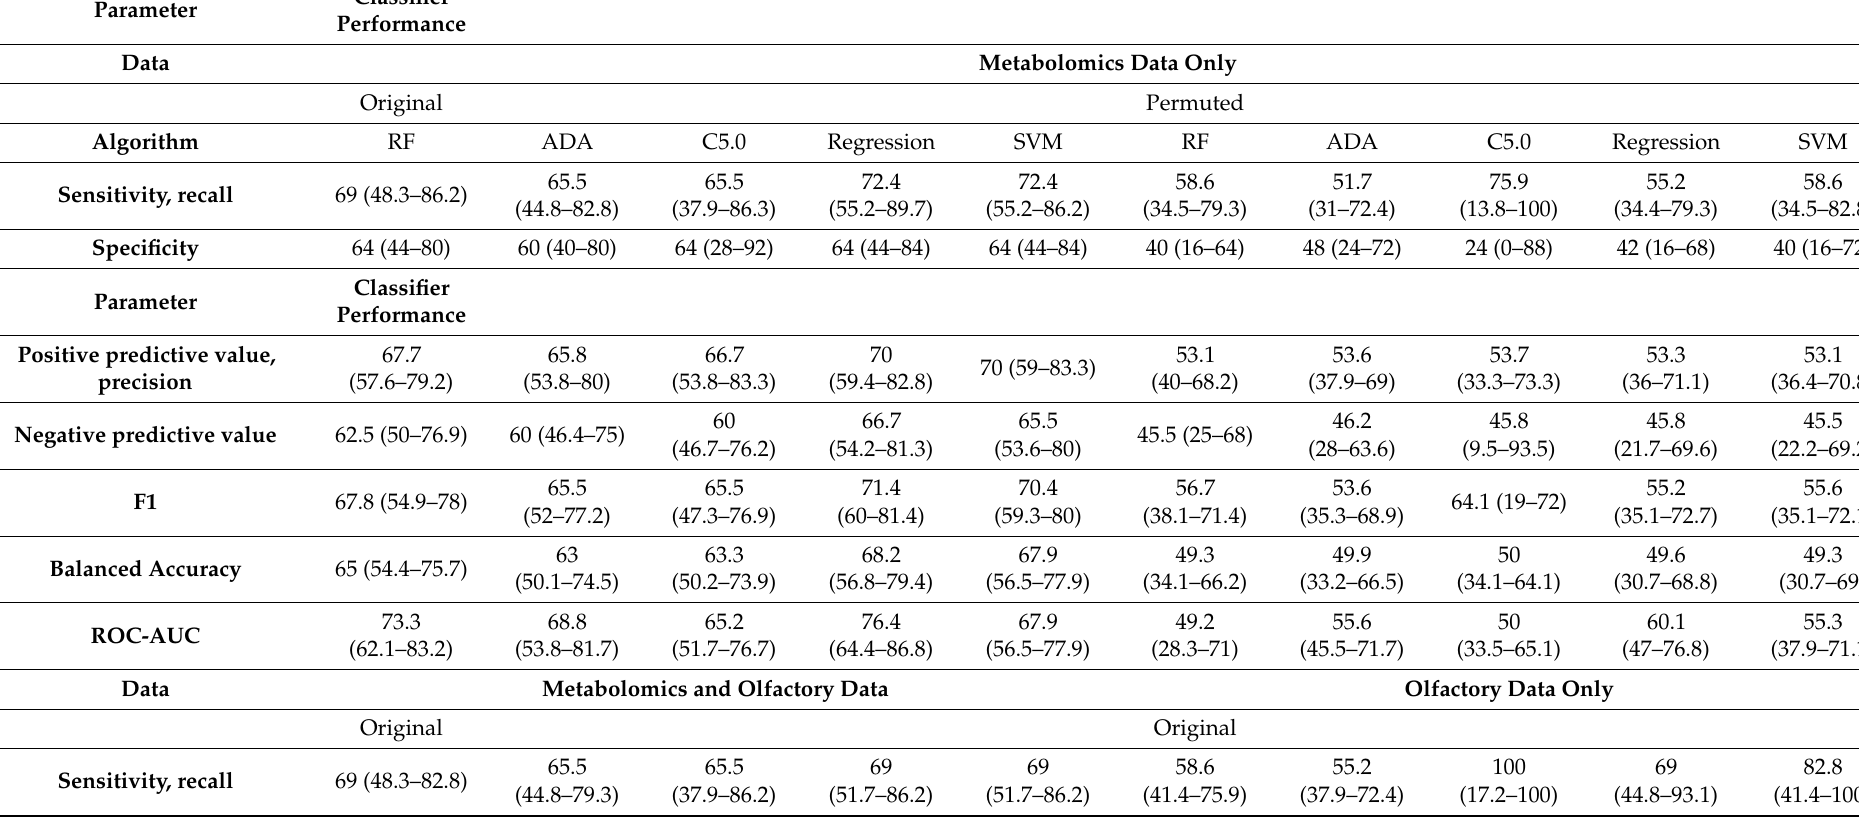
Table 3. Classification performance measures for correctly assigning subjects to two diabetes risk classes, either lower (FINDRISK scores ≤ 11) or higher (FINDRISK score > 11) risk, obtained when training five different classifiers (random forests (RF), boosted classification and regression trees (ADA), C5.0 non-hierarchical decision rules, logistic regression (regression), and support vector machines (SVM)) with the metabolomics or olfactory information. The results represent the medians and 95% confidence intervals of the performance measures obtained during 1000 runs using class-proportional random divisions of the data set into disjoint training (two-thirds of the data set) and testing (one third) data subsets. The classifiers were trained on the metabolomics information, comprising d = 15 markers, on the olfactory information, comprising d = 3 olfactory subtest results, and on both types of information. With the metabolomics information for which the classifiers were successfully trained, training was repeated with randomly permuted data, which served as a negative control to detect possible overfitting. Results obtained when training was performed with permuted data are only shown when the training with original data had been